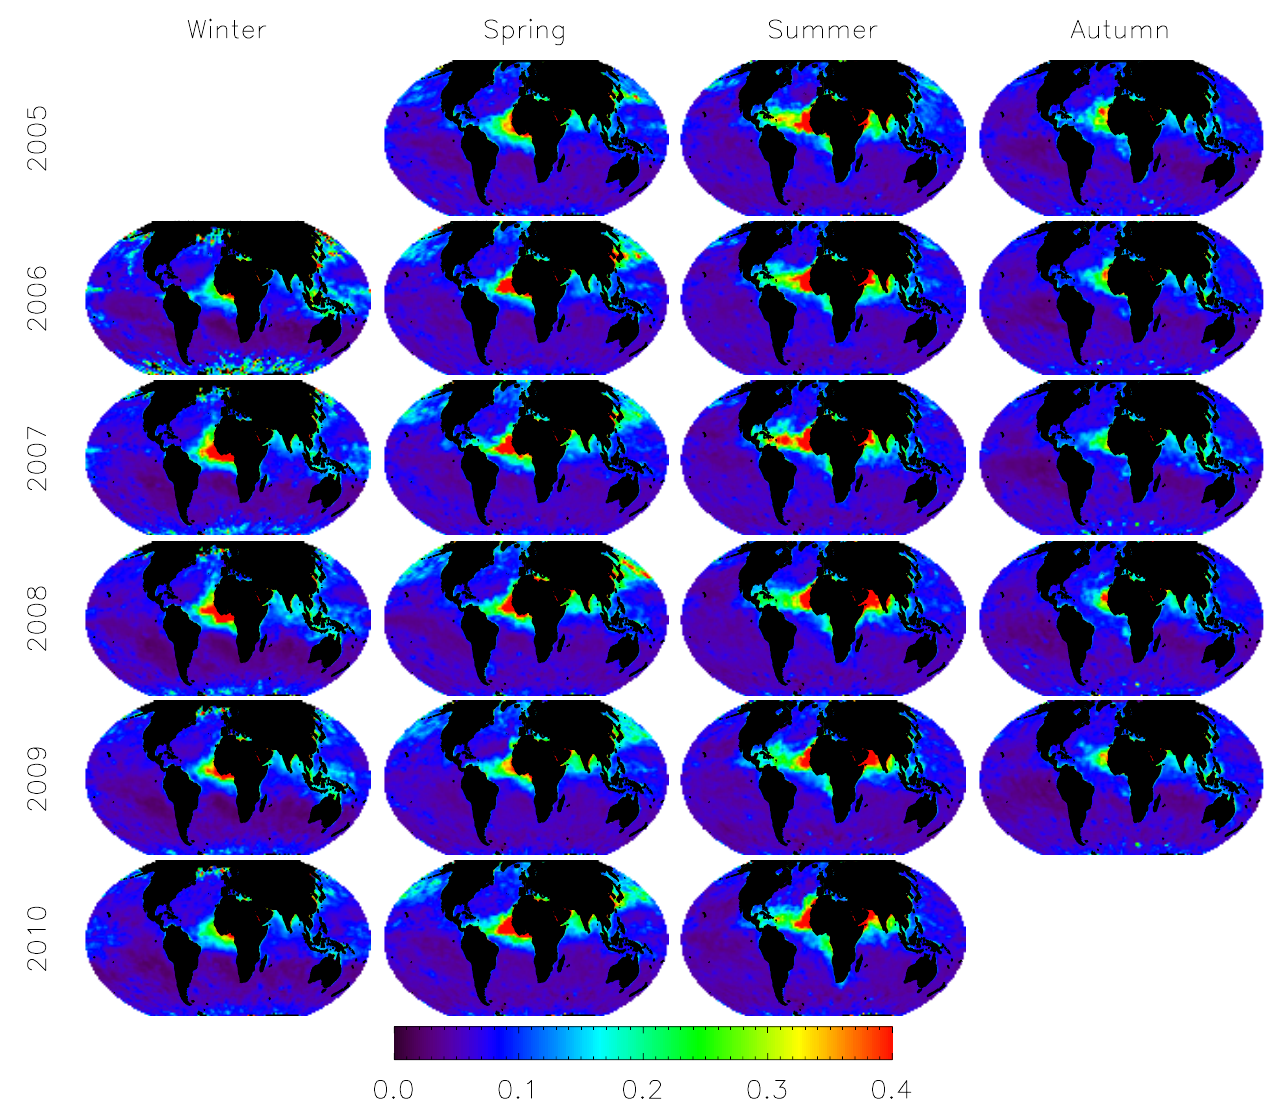
Fig. 1. AOD at 550nm resulting from the non-spherical coarse mode. Seasons are ordered from the left to the right (winter, spring, summer, autumn, respectively); years from the top to the bottom (from 2005 to